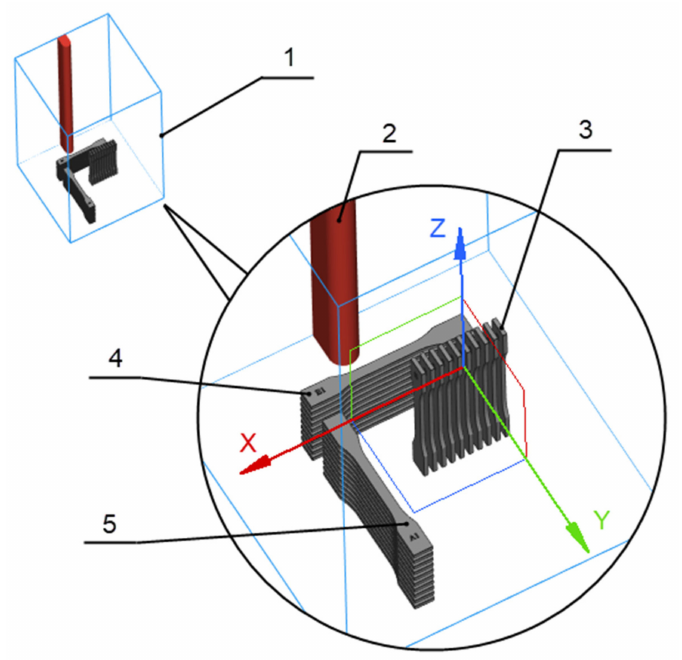
Figure 1. Part orientation and position in the 3D printer chamber; 1—Build Chamber EOS P396, 2—No Build Zone (red line), 3—Samples G1 (10 pcs), 4—Samples B1 (10 pcs), 5—Samples A1 (10